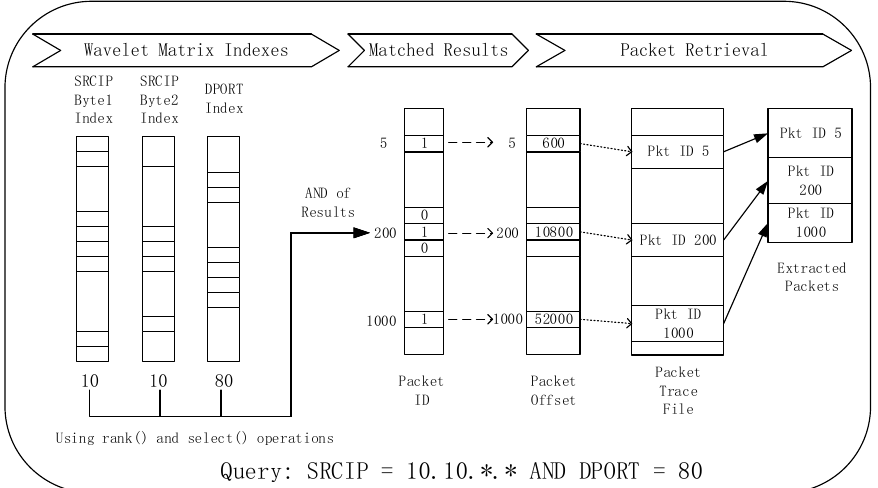
Figure 8. The procedure of packet lookup and extraction.